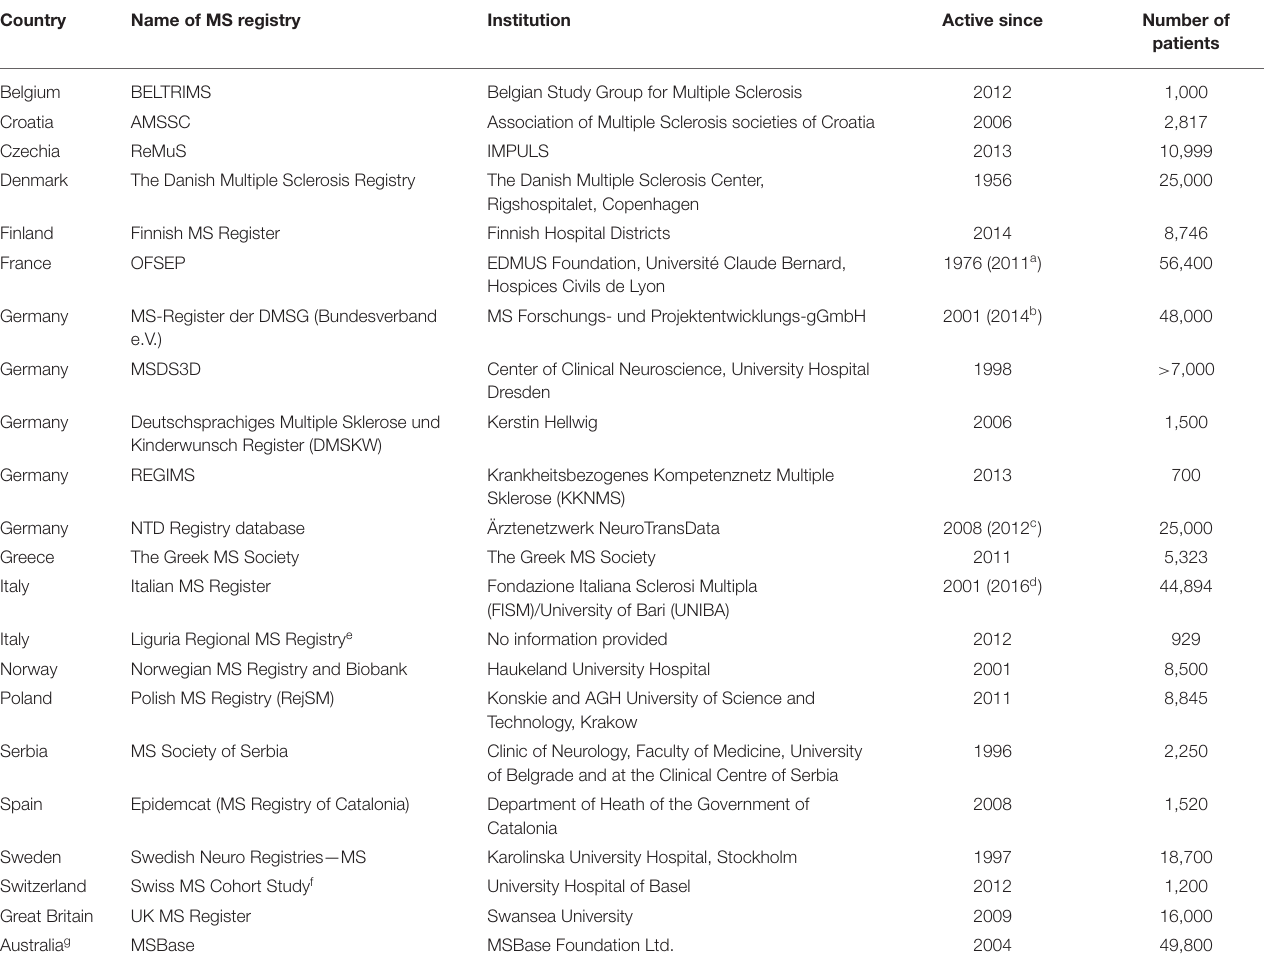
TABLE 1 | European MS registries [based on